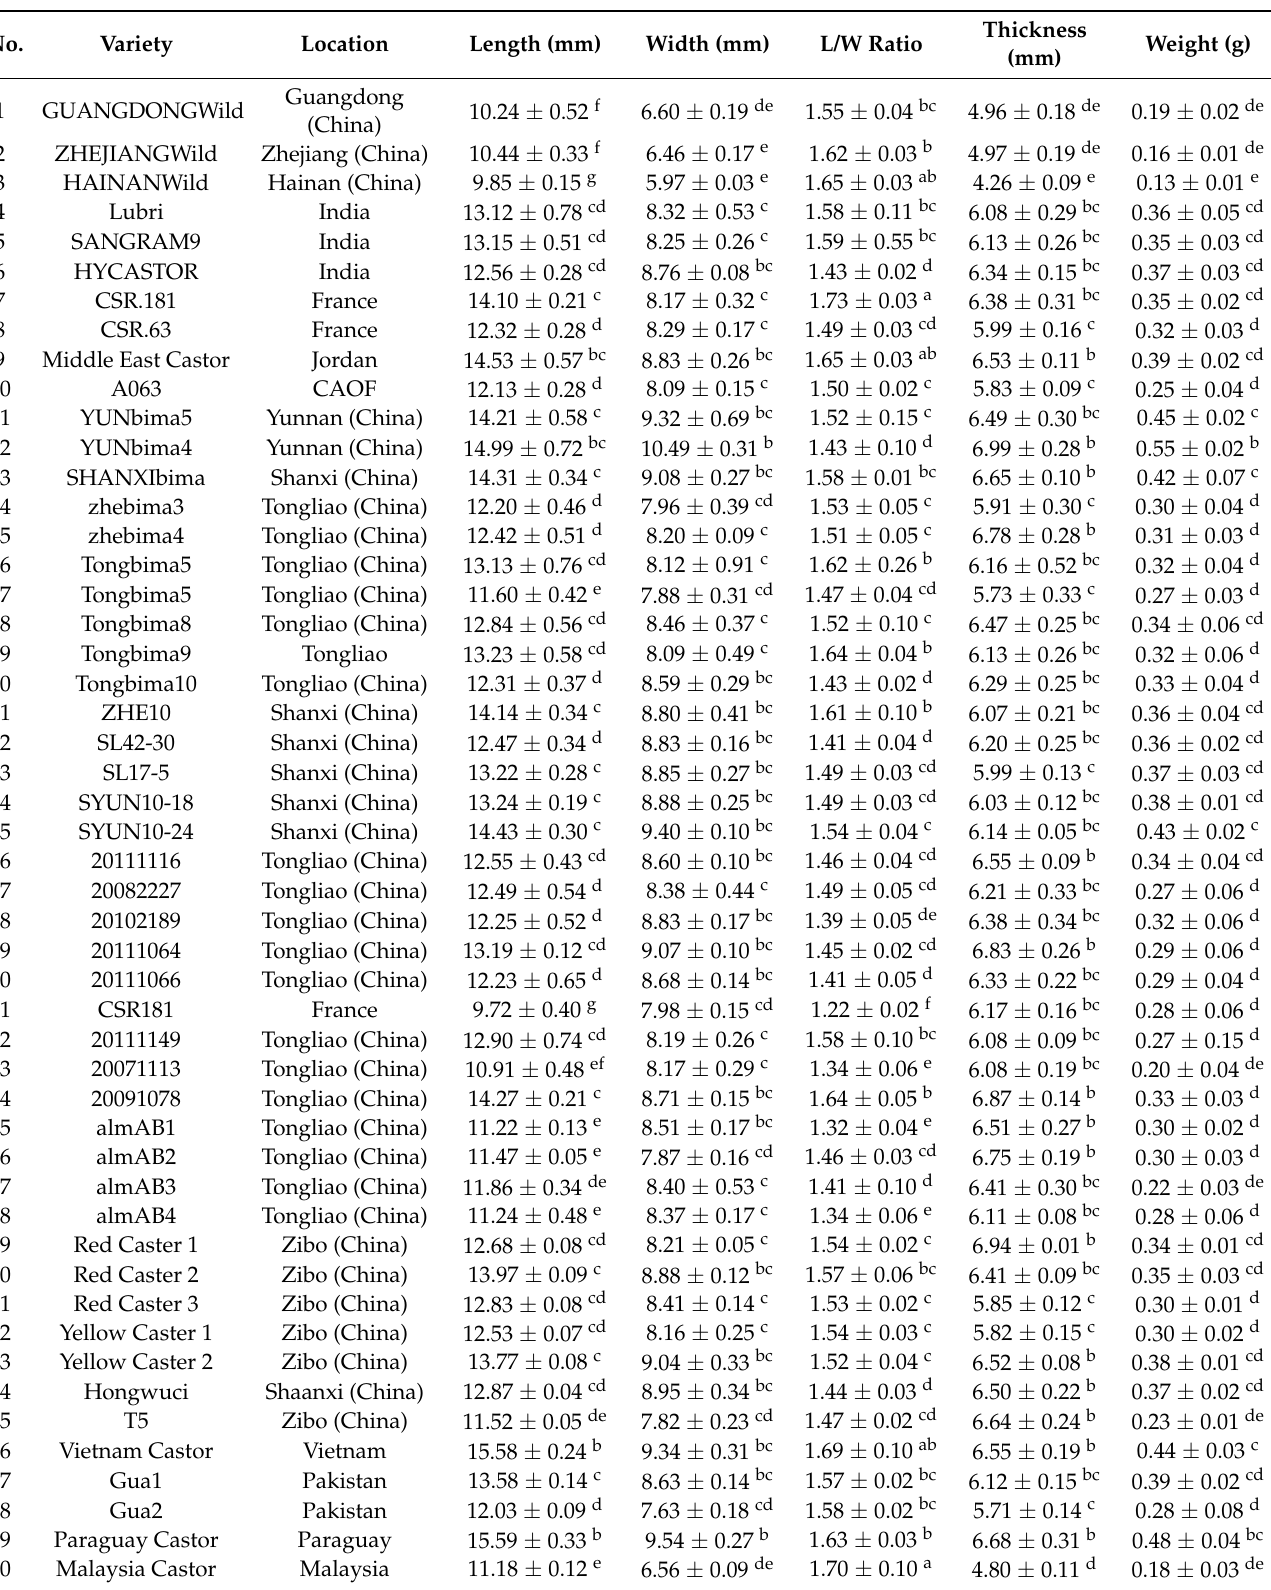
Table 1. List of the castor beans ( R. communis L.) included in the